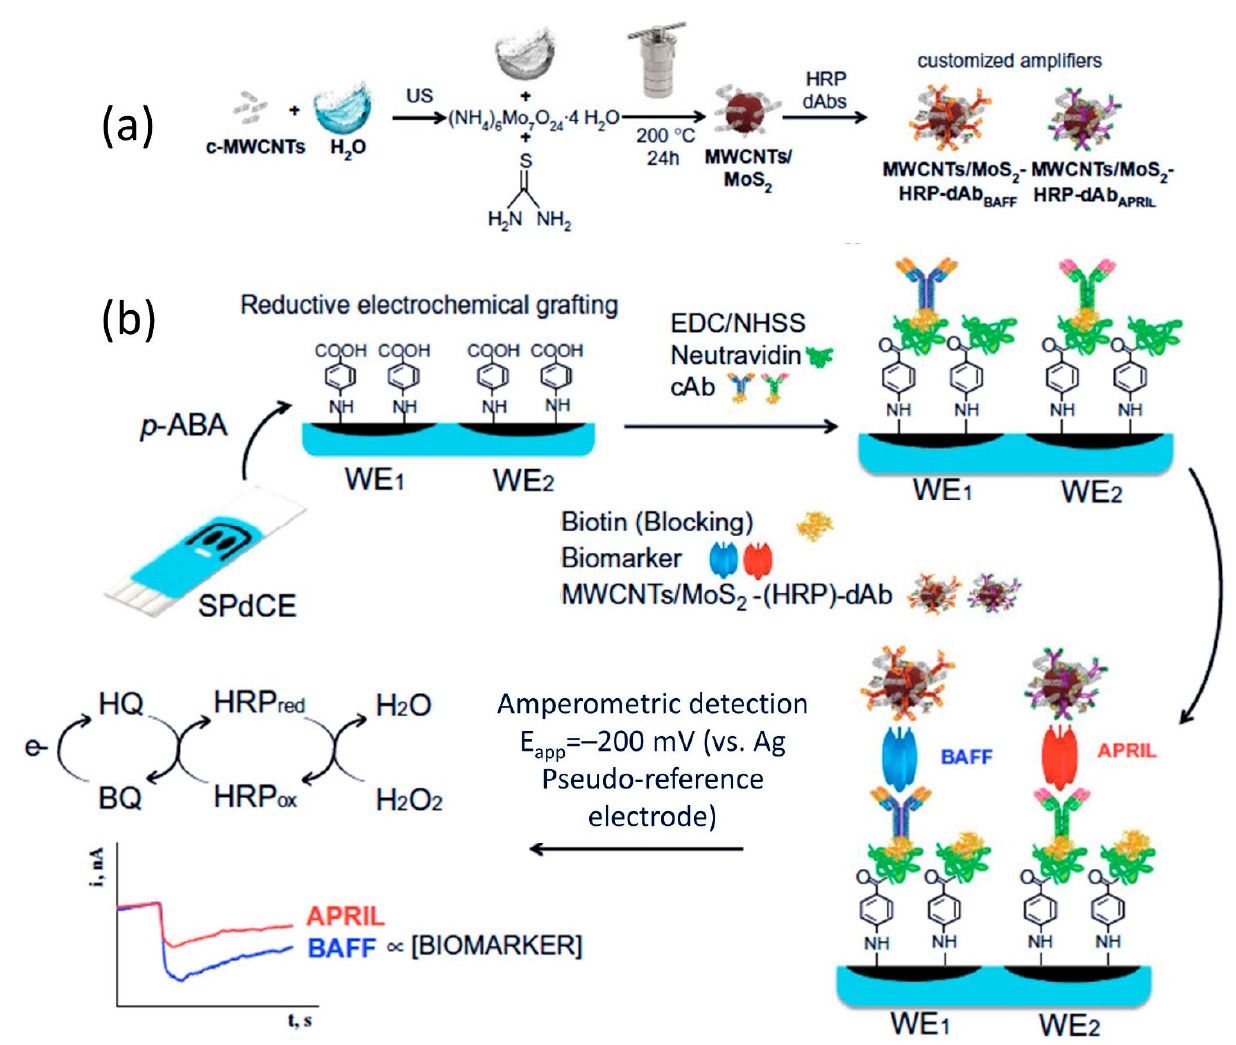
Figure 7. ( a ) A schematic of the fabrication of MWCNTs/MoS2(-HRP)-dAb nanocarriers and ( b ) their application on screen-printed dual carbon electrodes (SPdECs) for the determination of BAFF and APRIL biomarkers. Reprinted with permission from [135]. Copyright 2022 Springer Nature.